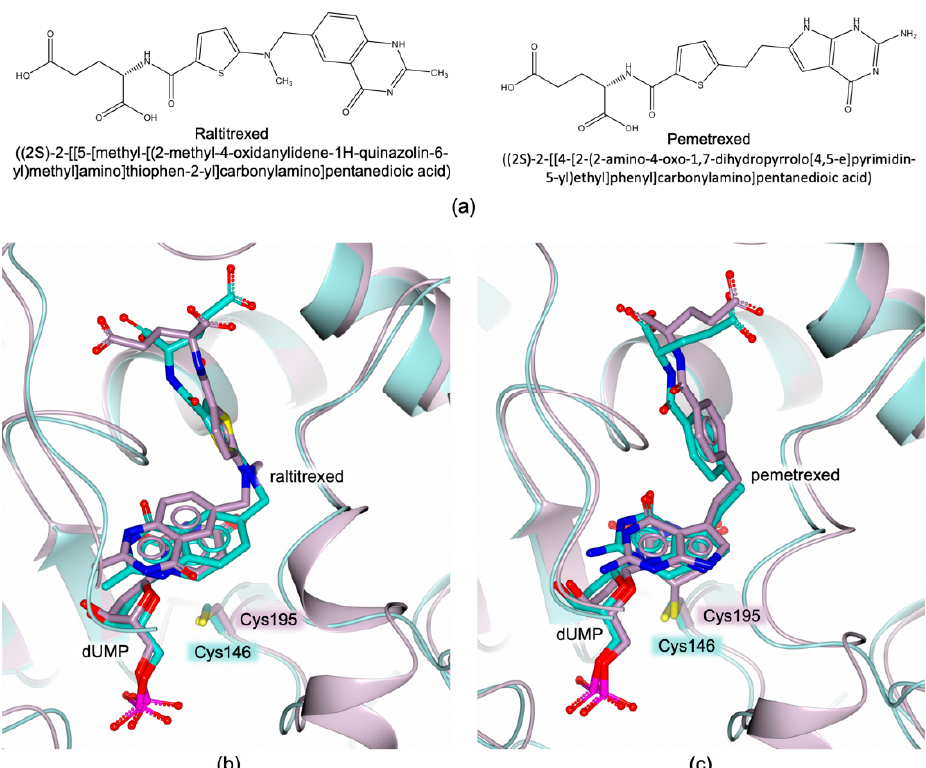
Figure 7. ( a ) Chemical structures of raltitrexed and pemetrexed. ( b ) Active site view of the